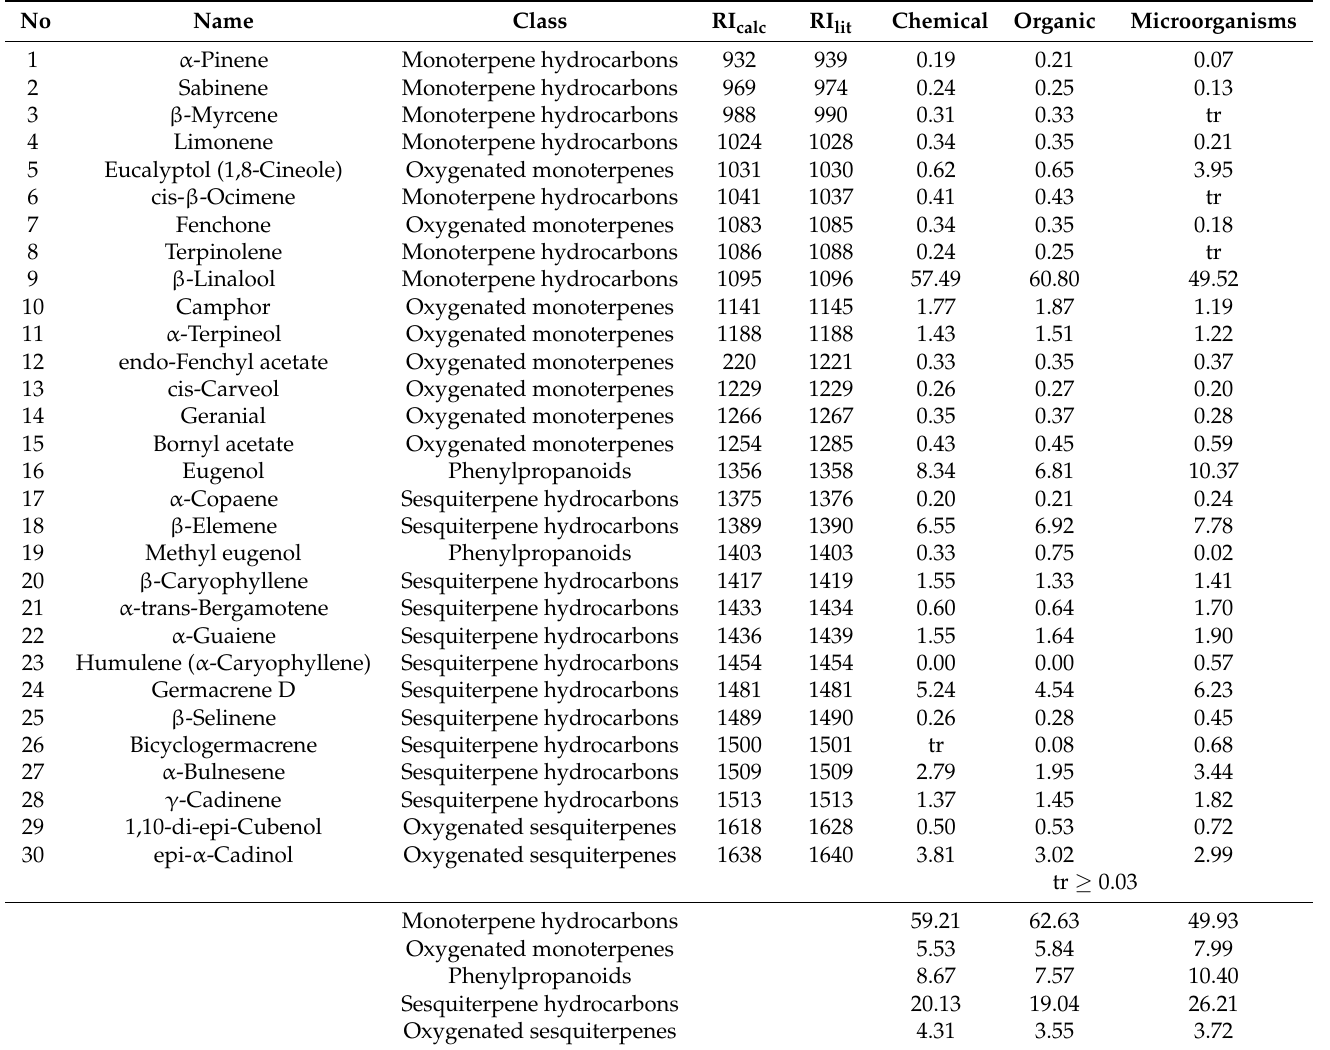
Table 12. Influence of fertilization on essential oil composition of ‘Serafim’